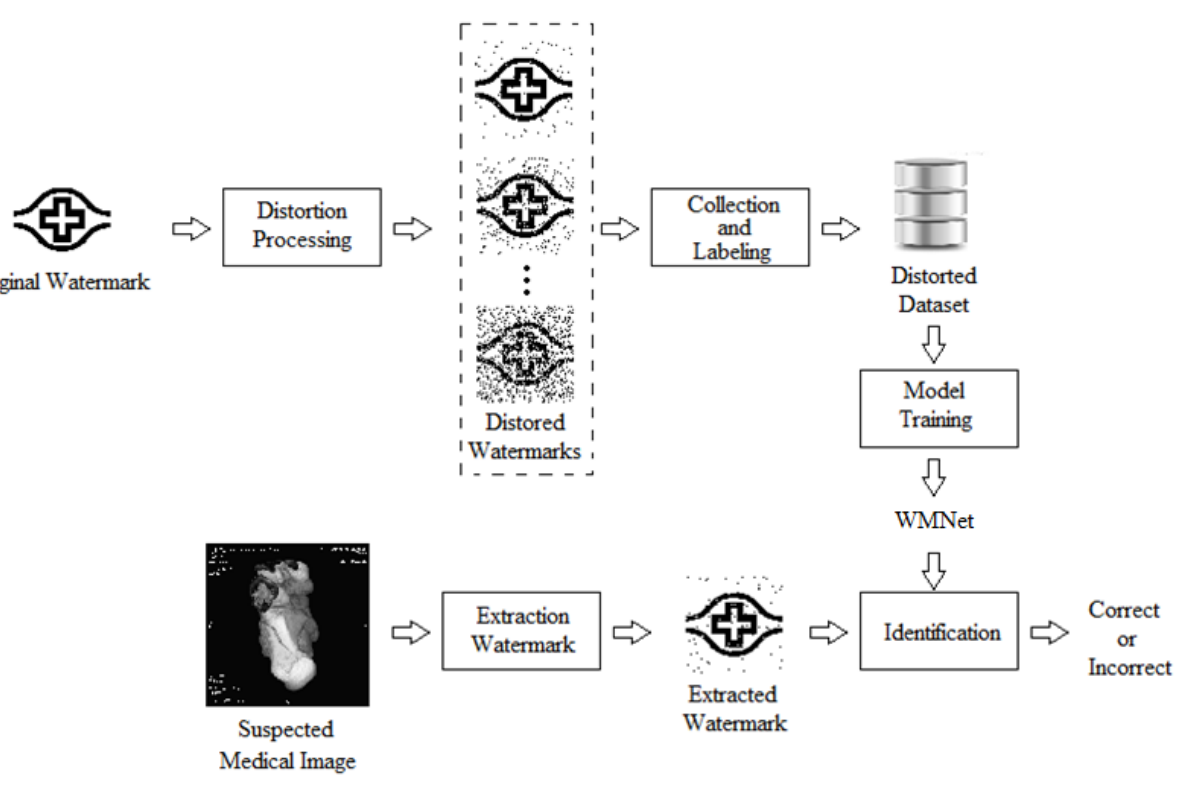
Figure 2. WMNet flow chart.